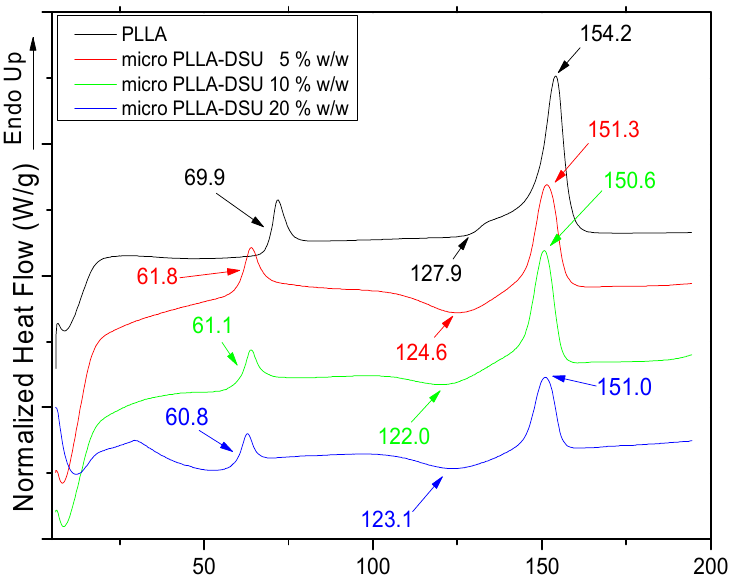
Figure 5. DSC thermographs of PLLA and PLLA-DSU microparticles.